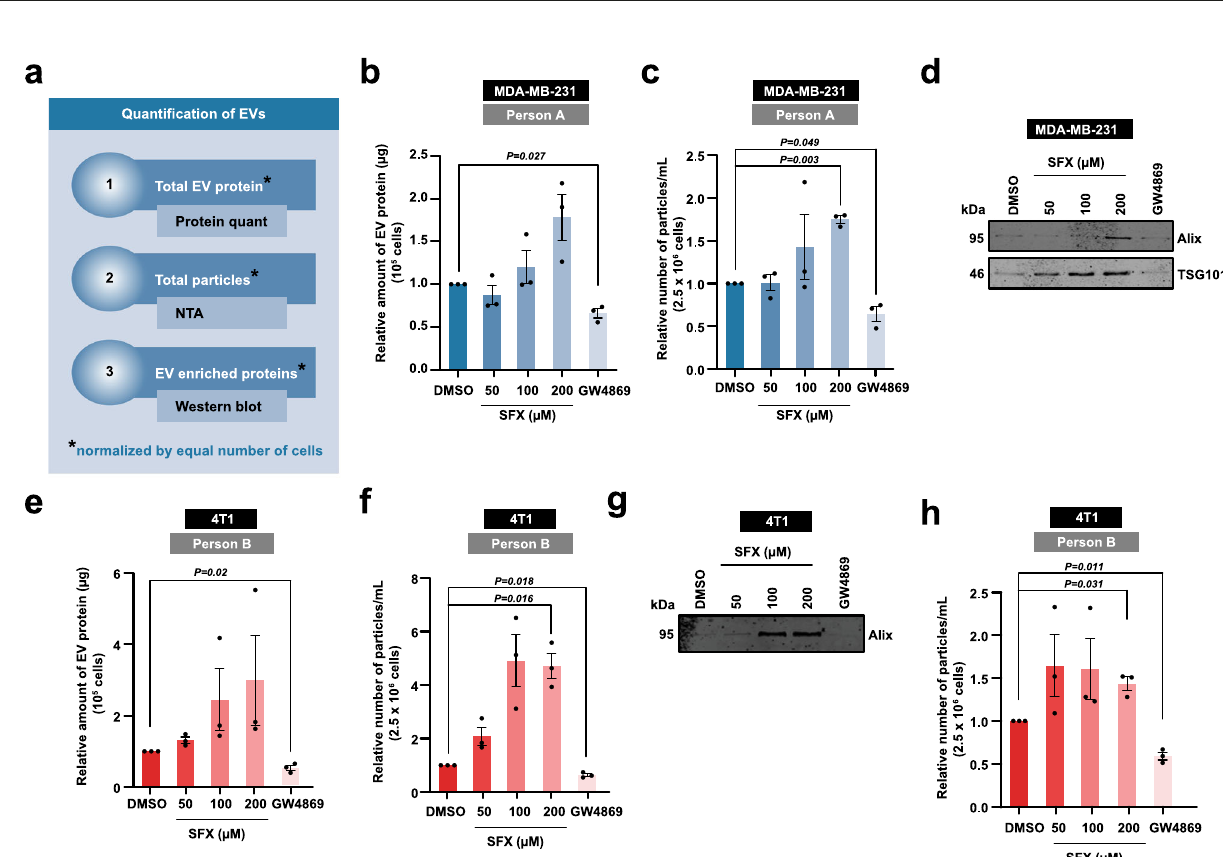
Fig. 1 Schematic representation of cell culture, drug treatment and sEV isolation by two groups. a Schematic representation of cell culture and drug treatment approaches. The cells were seeded and allowed to grow to 70 – 80% con fl uency in media supplemented with FCS. Upon attaining desired con fl uency, cells were washed with 1× PBS and subjected to drug treatment for 24 h in serum-free media. At treatment endpoint, conditioned media was harvested and subjected to sEV isolation. Live cell number was determined to normalise particles released to cell number. Similarly, Baek group seeded cells in a pre-de fi ned range and treated them with drug in serum-free media. b Protocol 1, schematic fl ow diagram depicting the methodology of sEV isolation and analyses as de fi ned by Baek group in the initial publication (Im et al. 13 ) and followed by Fonseka et al. (this study). Protocol 2, schematic fl ow diagram depicts the methodology of sEV isolation and analyses as reported by Baek group when approached. The variations in the methodology from the original manuscript (Im et al.) is marked (*). Protocol 2 was also adapted by Fonseka et al. to include the variations (*) suggested by Baek group. Protocol 3, standardized and optimized method of sEV isolation in EV depleted serum used in Mathivanan laboratory was also used to collect sEVs post treatment with SFX.